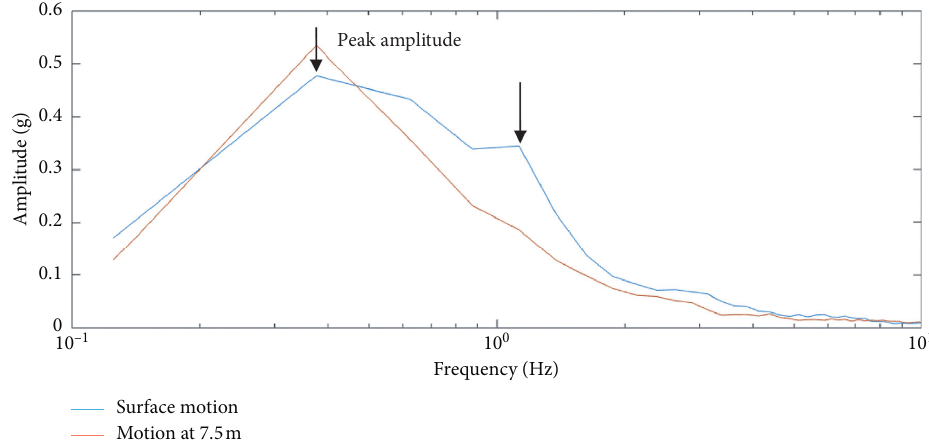
Figure 10: Marginal spectra for two earthquake time histories.